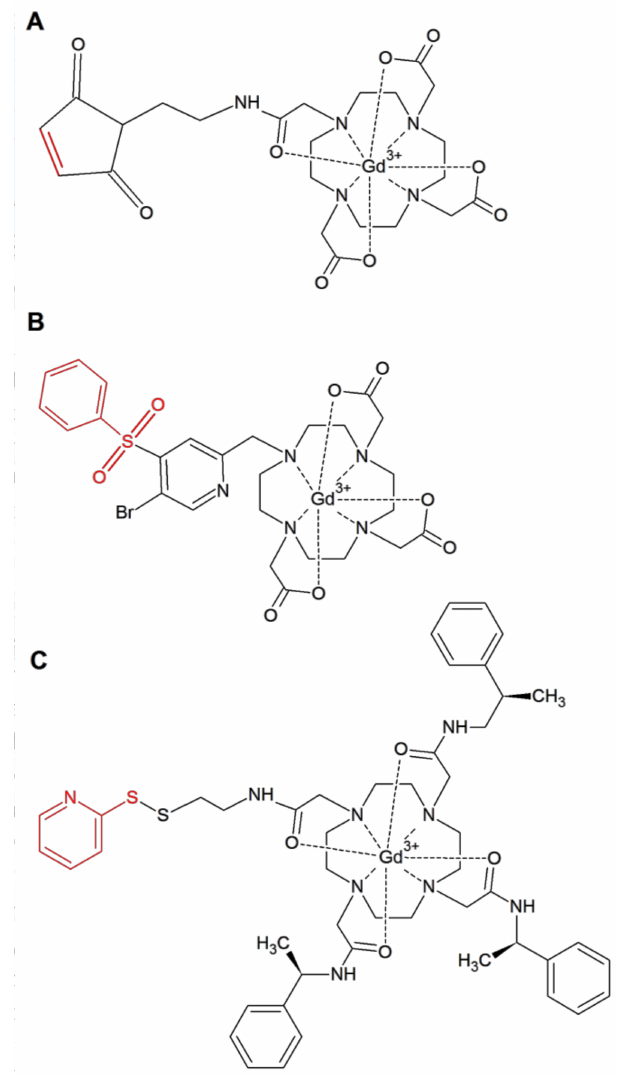
Figure 2. Chemical structures of the spin labels that were used in this work: ( A ) Gd(III)-DOTA- maleimide and ( B ) Gd(III)-DO3A, used to label ubiquitin. ( C ) Gd(III)-C2, used to label MdfA. The leaving group of the labeling reaction is indicated in